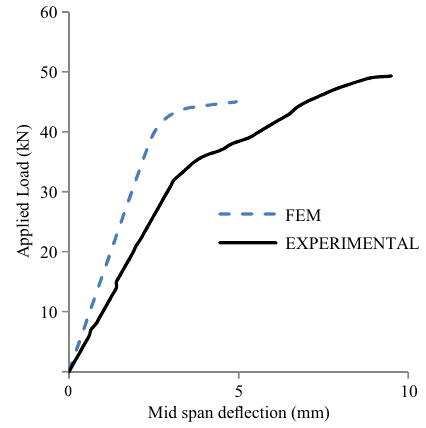
Fig. 6. Load vs mid span deflection for beam SB2 Fig. 7. Load vs deflection curve for plain web-beam (PWB)